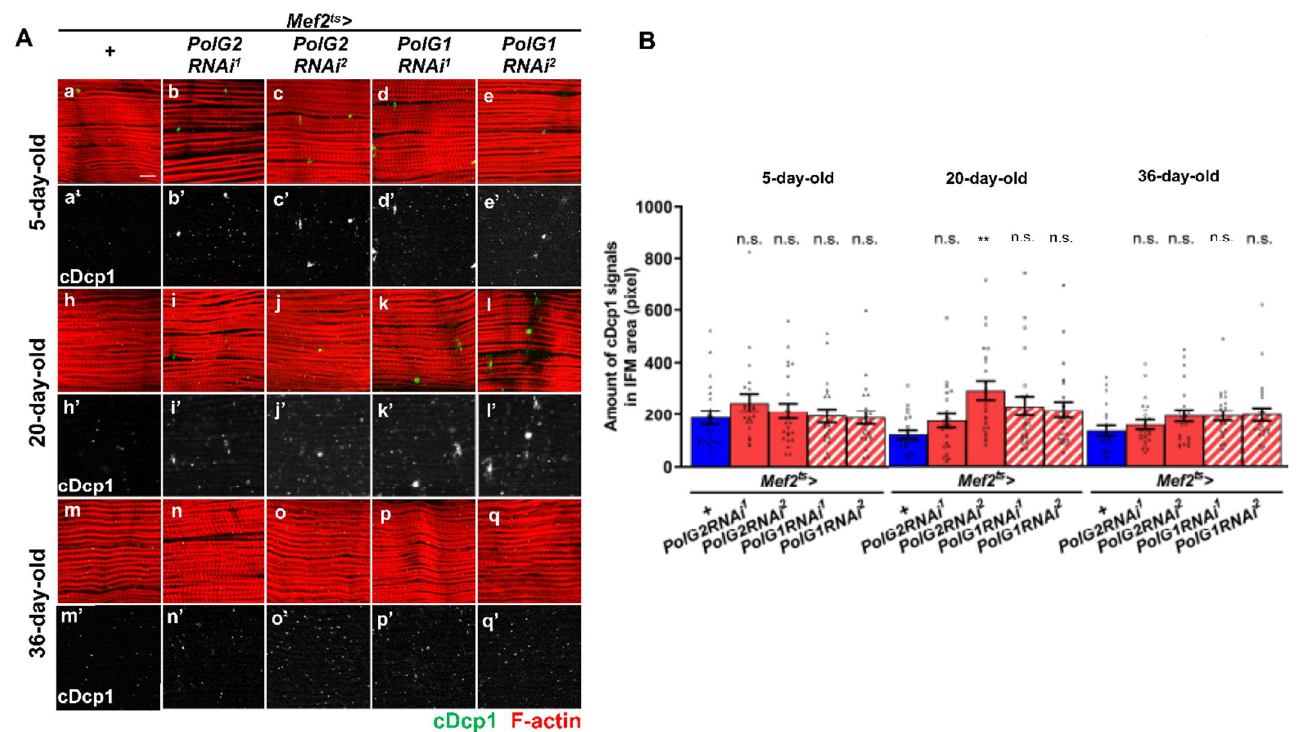
Figure 6. Immunostaining of adult IFMs harboring polγRNAi with anti-cDcp1 antibody and quan- tification of the foci representing activation of the effector caspase. ( A ) Immunostaining of IFMs collected from 5-, 20-, and 36-day-old control adults ( Mef2 ts > + ) and adults harboring muscle-specific PolG2RNAi and PolG1RNAi ( Mef2 ts > PolG2RNAi 1 , Mef2 ts > PolG2RNAi 2 , Mef2 ts > PolG1RNAi 1 , and Mef2 ts > PolG1RNAi 2 ) with anti-cDcp1 antibody (green in a – q , white in a’ – q’ ). Myofibrils of the IFMs are visualized by phalloidin staining (red). Scale bar: 10 μm. ( B ) Quantification of the cDcp1 foci in the IFMs from 5-, 20-, and 36-day-old control adults ( Mef2 ts > + ( n = 22 for 5-day-old, n = 23 for 20-day-old, and n = 22 for 36-day old)) and adults harboring muscle-specific PolG2RNAi and PolG1RNAi ( Mef2 ts > PolG2RNAi 1 ( n = 22, 23, 24) Mef2 ts > PolG2RNAi 2 ( n =23 for all three age groups), Mef2 ts > PolG1RNAi 1 ( n = 22, 23, 23) and Mef2 ts > PolG1RNAi 2 2 ( n = 23 for all three age groups). (** p < 0.01, n.s.; not significant, one-way ANOVA with Bonferroni’s multiple comparisons test). Error bars; s.e.m.